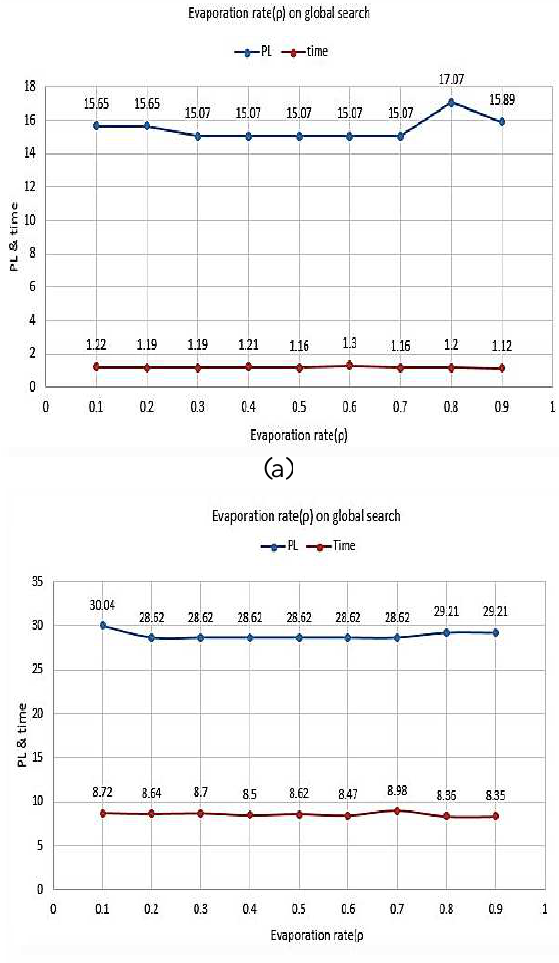
Fig. 9. Effect of evaporation factor ( length and execution time for (a) 10 (b) 20 × 20